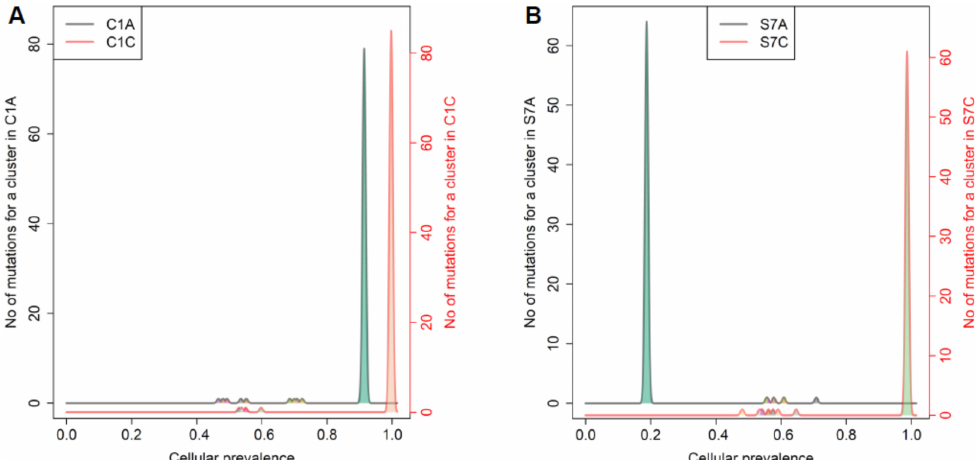
Figure 5. Inference of evolutionary fitness landscape using cellular prevalence of mutation clusters from PyClone analysis in representative colorectal and gastric tumors. The representative colorectal (C1) ( A ) and gastric (S7) ( B ) cases show higher peaks by numbers of mutations for a cluster ( y -axis) and higher cellular prevalence with a smaller number of mutational clusters ( x -axis) in carcinomas, suggesting stabilizing mutational selection during cancer evolution. The analyses revealed that the majority of the cases (e.g., 7 / 11 colorectal cases; C1, C2, C3, C4, C7, C8, and C11 and 6 / 10 gastric cases; S3, S4, S6, S7, S8, and S9) showed sharper fitness peaks in carcinomas than in